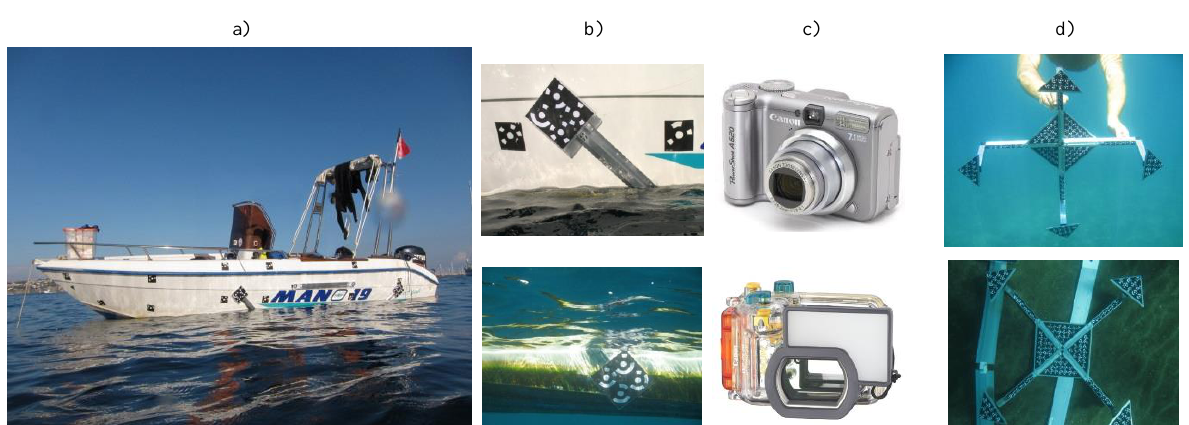
Figure 6. – The 6 m pleasure boat surveyed with the proposed technique with the attached photogrammetric targets and ODs (a). One of the ODs seen above and below the sea level (b). The consumer grade digital camera with its underwater camera housing employed for the survey (c). The portable volumetric rigid frame made with photogrammetric targets used for the underwater camera calibration